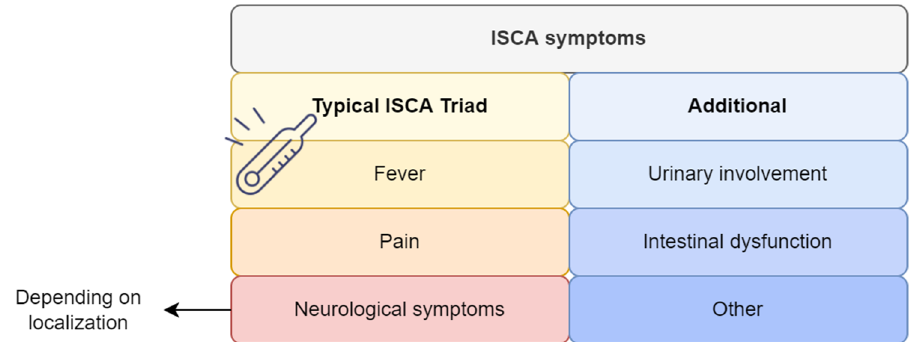
Figure 5. The typical clinical features of intramedullary spinal cord abscesses. Legend: ISCA—intramedullary spinal cord abscess .